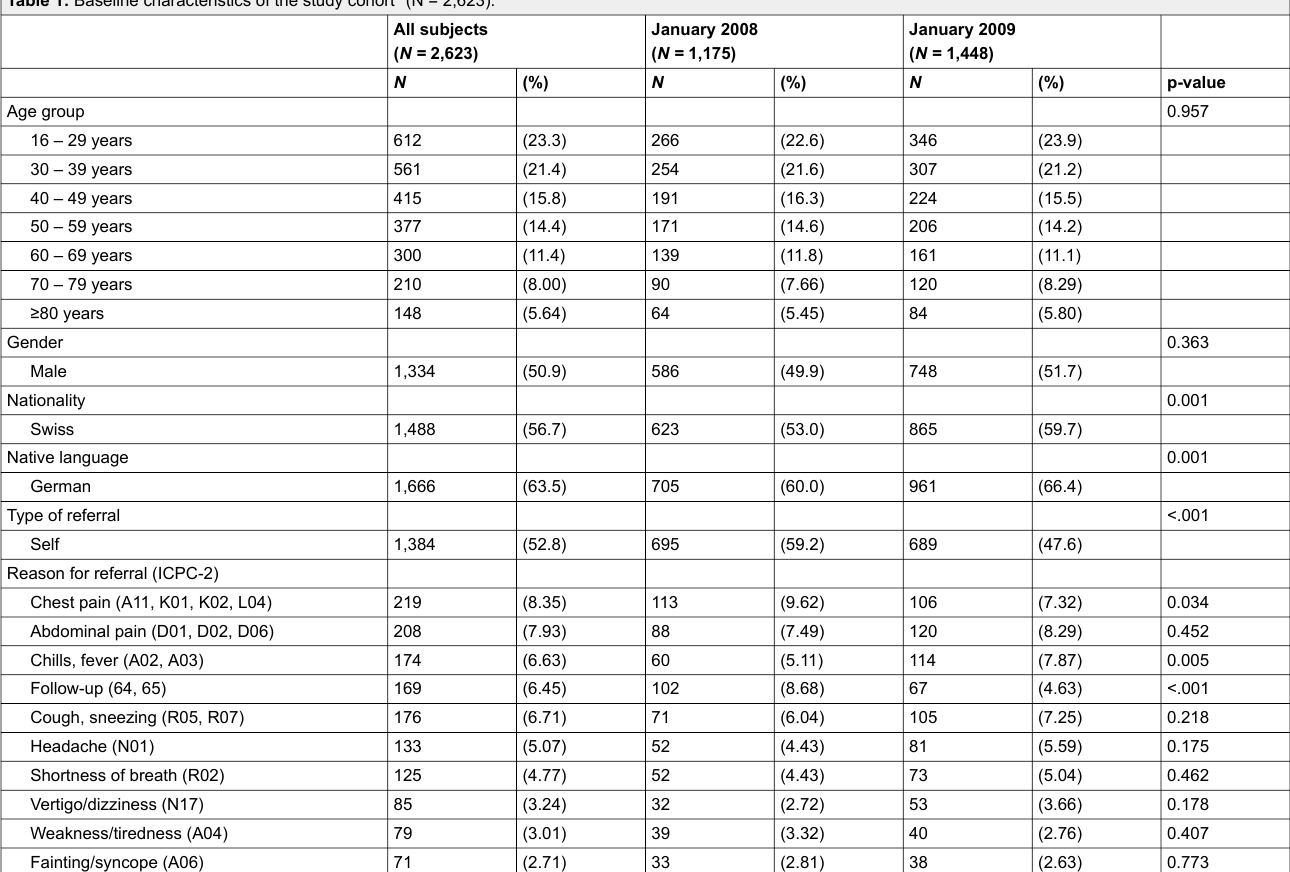
Table 1: Baseline characteristics of the study cohort* (N =